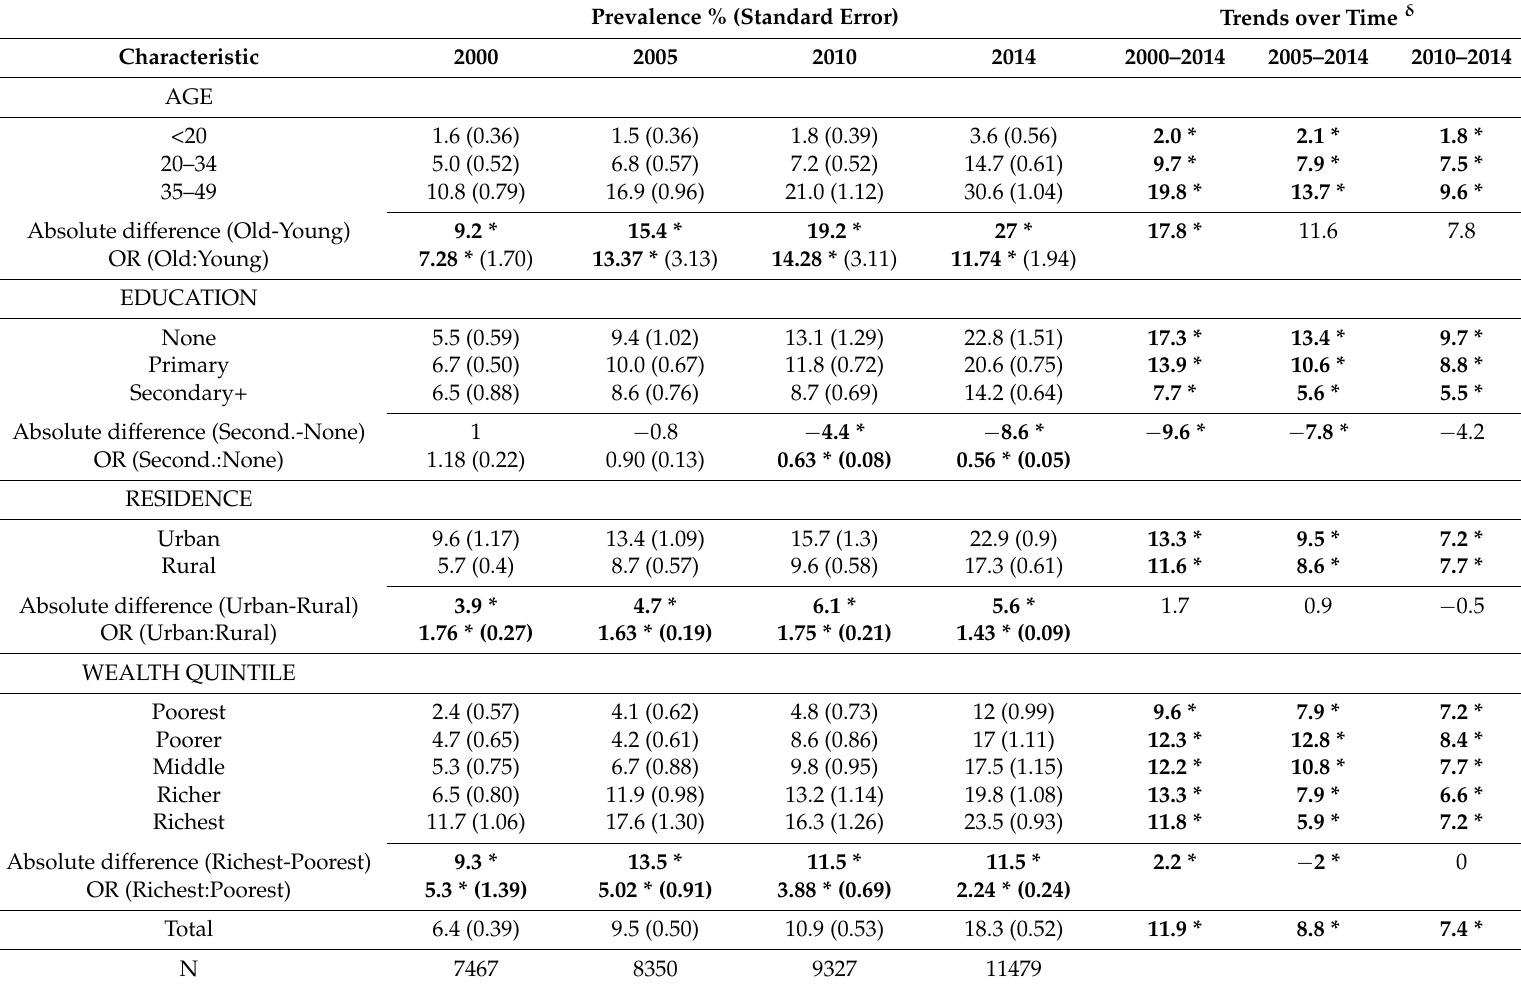
Table 3. Prevalence of overweight in women in the four surveys according to their social characteristics. Prevalence % (Standard Error) Trends over Time